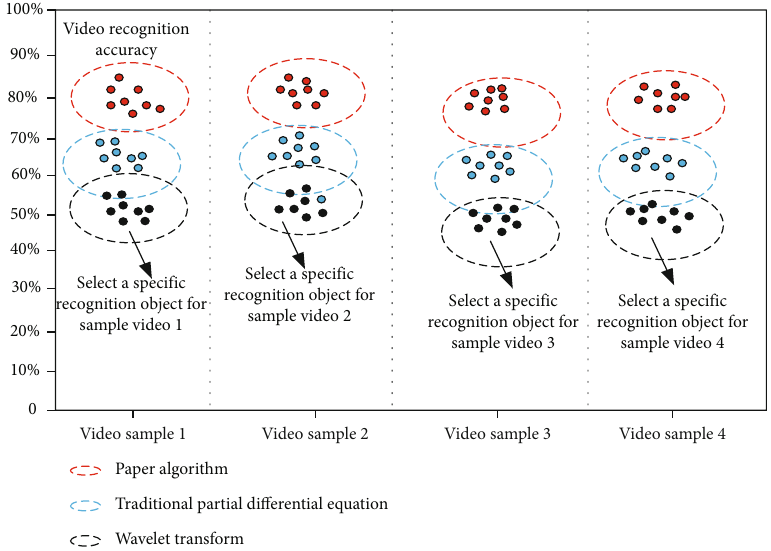
Figure 7: Curve of recognition accuracy of di ff erent algorithms for established targets under four groups of sample